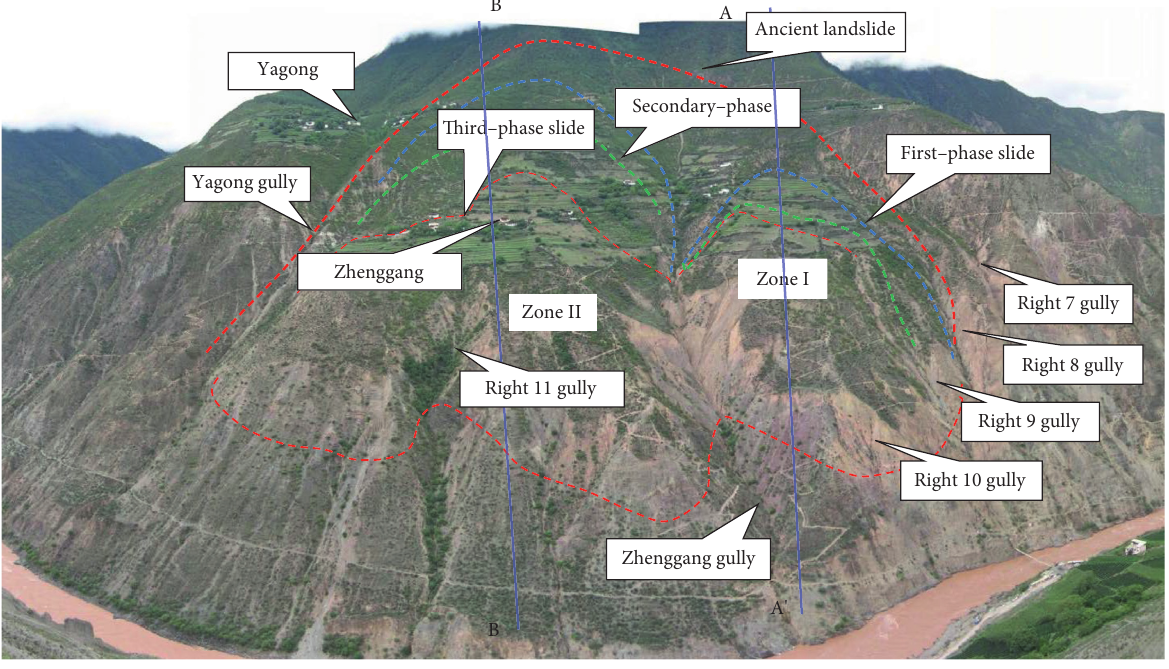
Figure 3: Front view of the Zhenggang